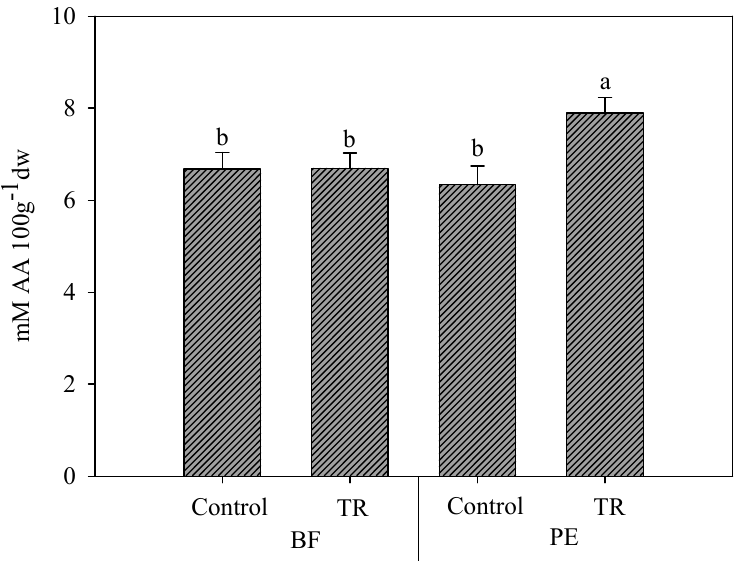
Figure 3. E ff ect of mulching films (brown photoselective film (BF) and black polyethylene (PE)) and Trichoderma application (untreated—Control and treated—TR) on hydrophilic (HAA) antioxidant activity of lettuce leaves. All data are expressed as mean; n = 3.